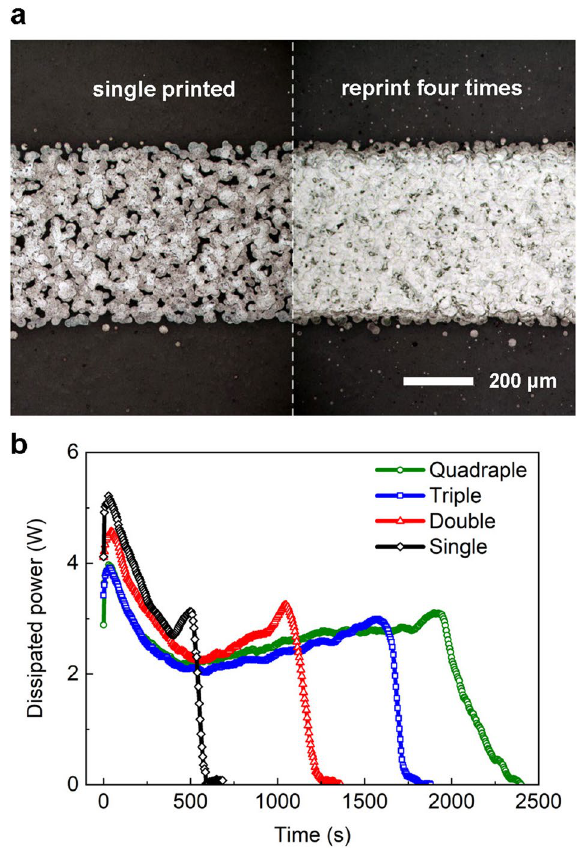
Figure 3. ( a ) Optical images of single- and quadruple-printed electrodes. ( b ) Power is delivered to the plasma as a function of time to show the lifespan of FXDBD based on the number of